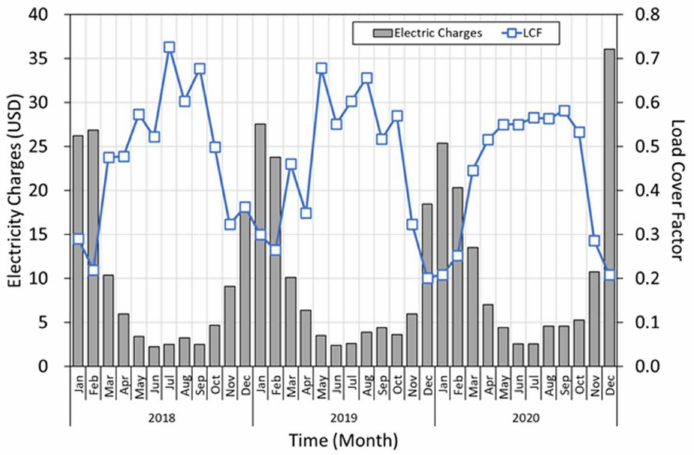
Figure 12. Monthly electricity charges and load cover factor of Gwangdeok house. The electricity charges were almost linearly proportional to the import electricity (R 2 = 0.9959), as shown in Figures 6 and 7. On the other hand, the load cover factor was inversely proportional to the electricity charges (R 2 = 0.7684). The higher the LCF, the lower the amount of power received and the lower the electricity